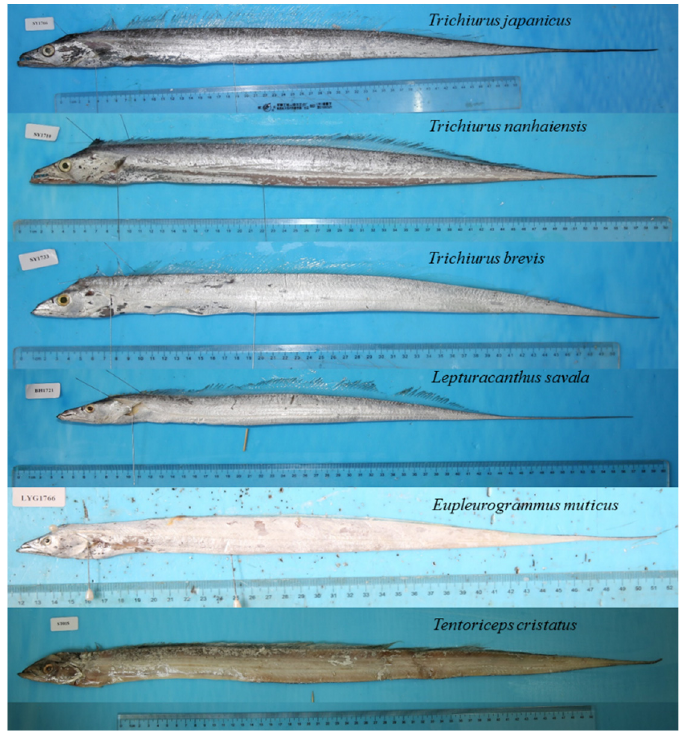
Figure A4. Photos of six species of Trichiuridae in the coastal waters of China.